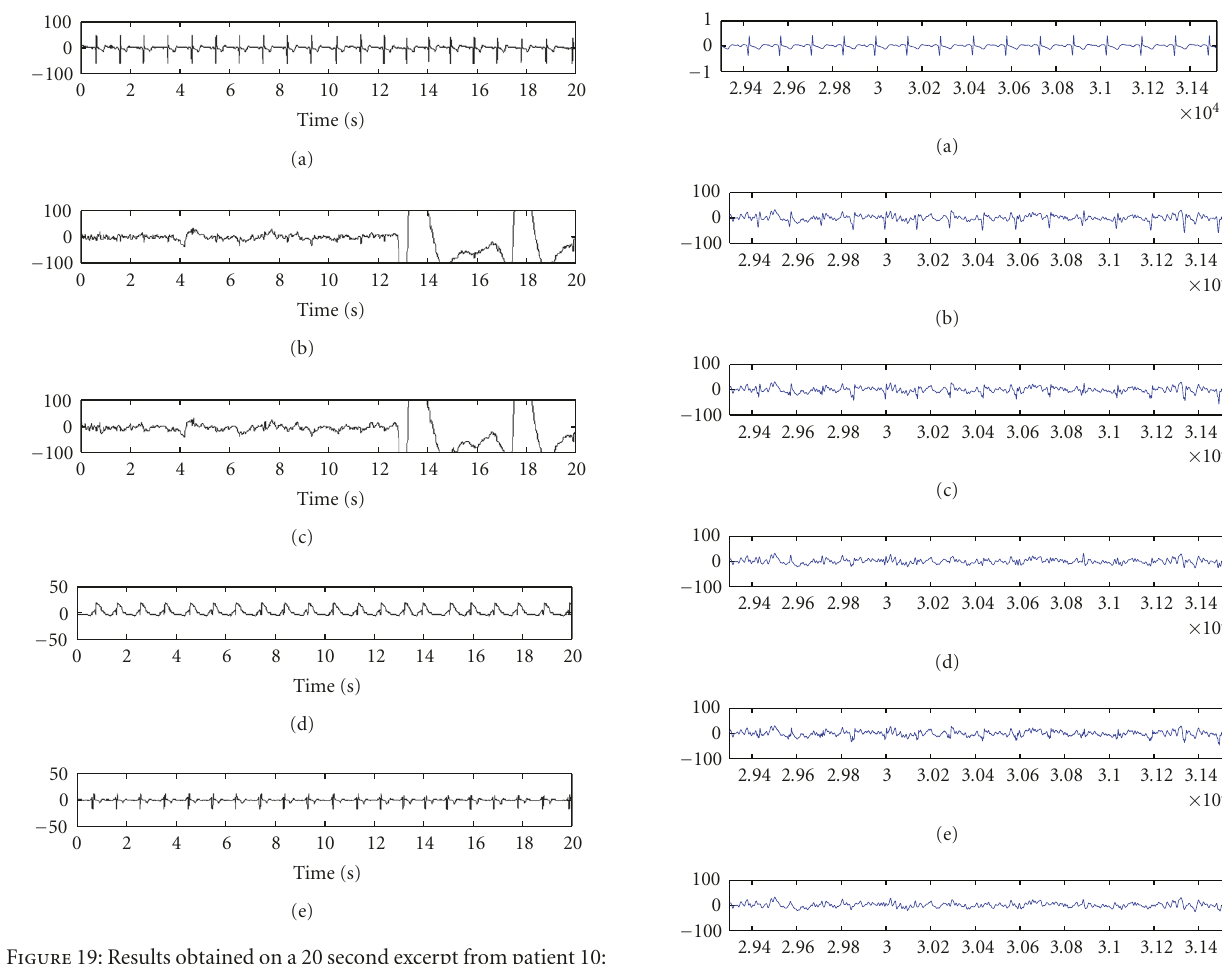
Figure 19: Results obtained on a 20 second excerpt from patient 10: (a) ECG, (b) corrupted signal, (c) correction by EAS, (d) estimate of the cardiac interference by the EAS methods, (e) estimate of the cardiac interference by ICA-EA.